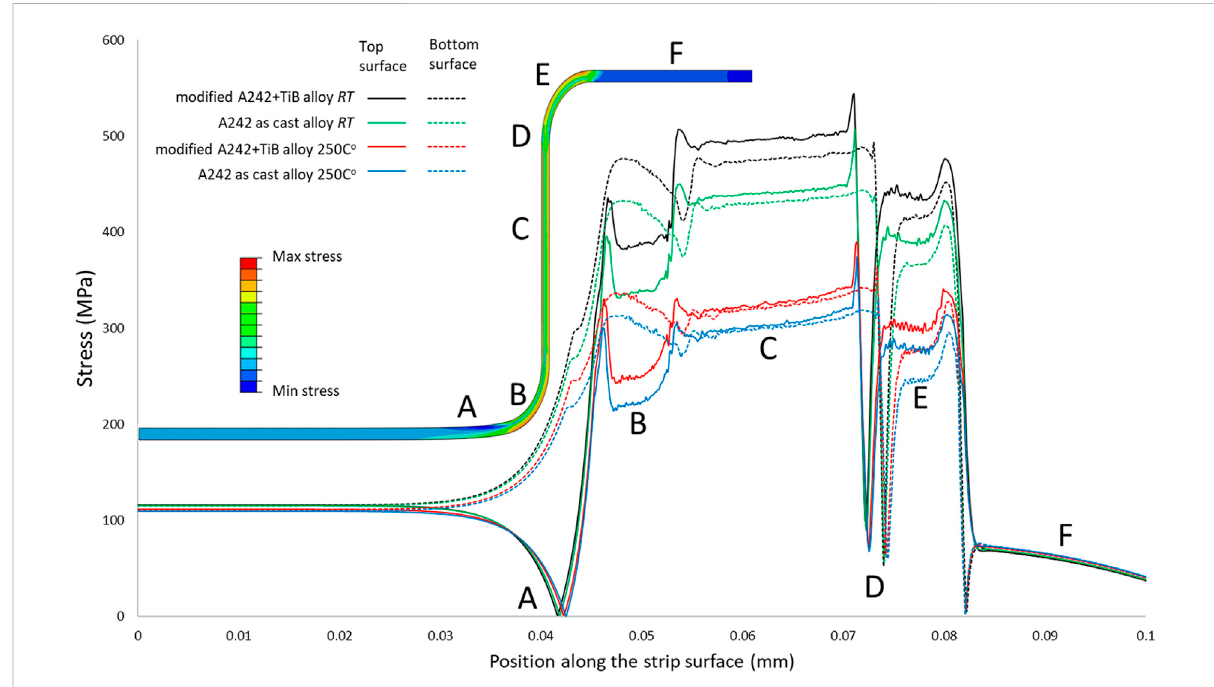
Stress variation along the deformed strip at various locations for both alloys at RT and 250C o